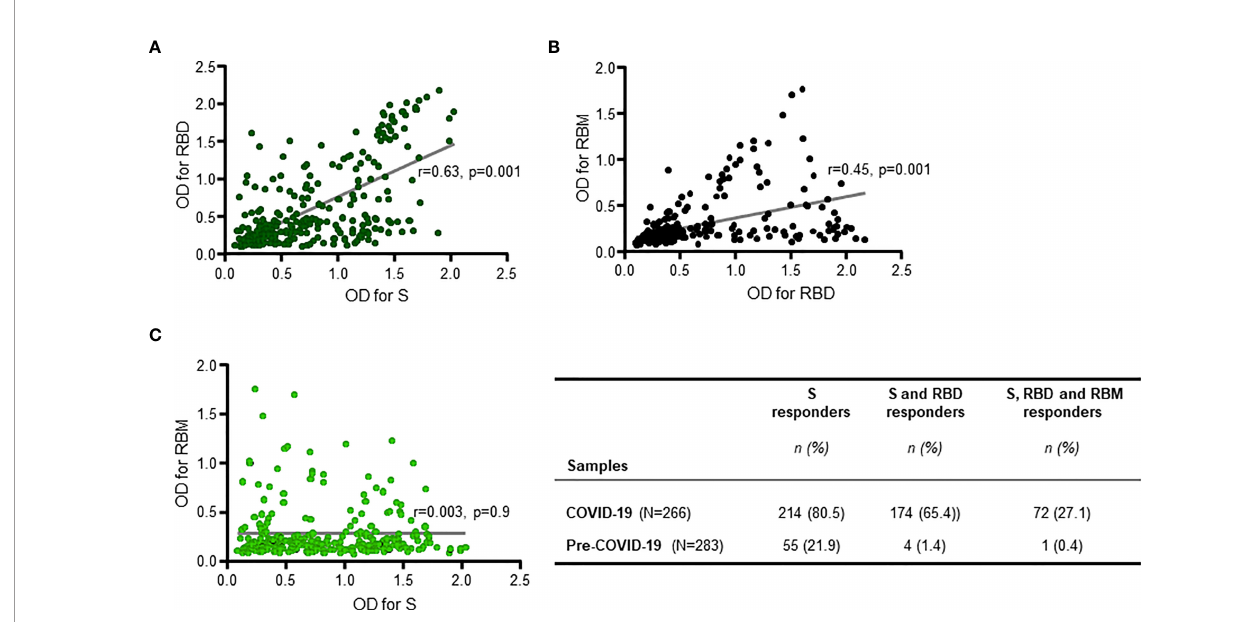
FIGURE 2 | Positive responder samples from COVID-19 patients simultaneously recognizing two or all three antigens. There was a signi fi cant positive correlation between antibody responses (antibody optical density (OD)) against S and receptor-binding domain (RBD) (R = 0.63, p = 0.001 (A) ), and between antibody responses against RBD and receptor-binding motif (RBM) ((R = 0.45, p = 0.001 (B) ), but not for antibody responses against S and RBM (R = 0.003, p = 0.9 (C) ). The two-sided Spearman ’ s rank correlation test was used to determine p - and R-values. The gray lines are the lines of best fi t for each scatter diagram. The table shows the number (n) and prevalence (%) of responder samples recognizing only S, or only S and RBD, or recognizing all three antigens